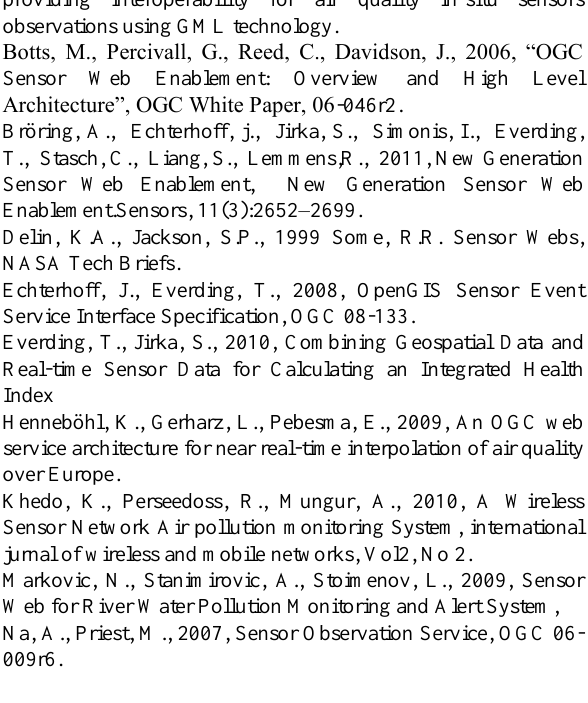
Figure 4. Accessing sensor observation using various filters For the implementation of described system open source web